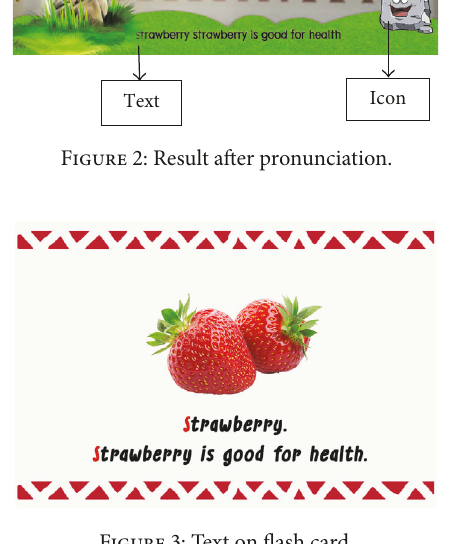
Figure 3: Text on flash